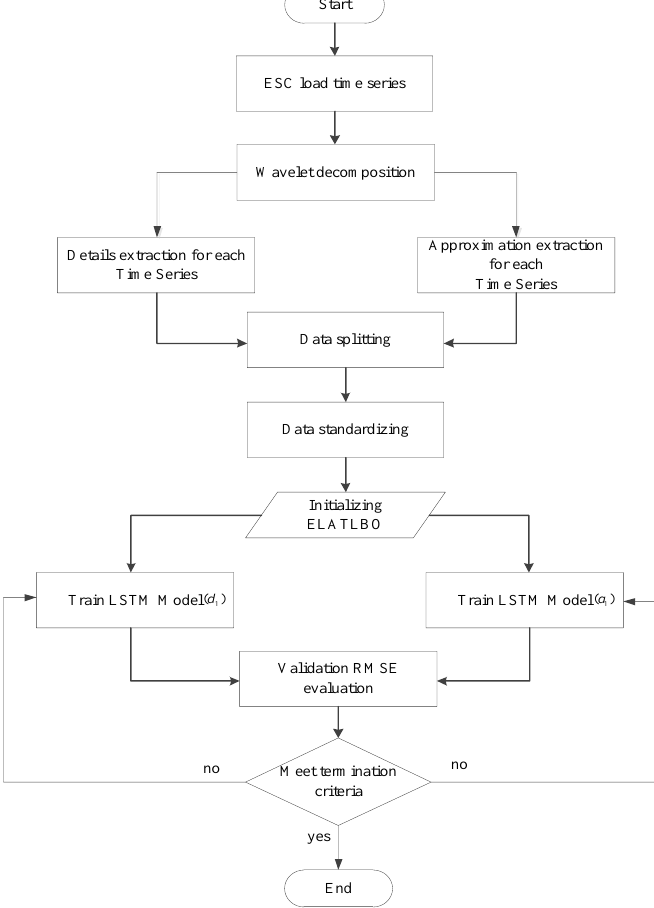
Figure 3. Flowchart of training and fine-tuning of the LSTM model for demand forecasting.